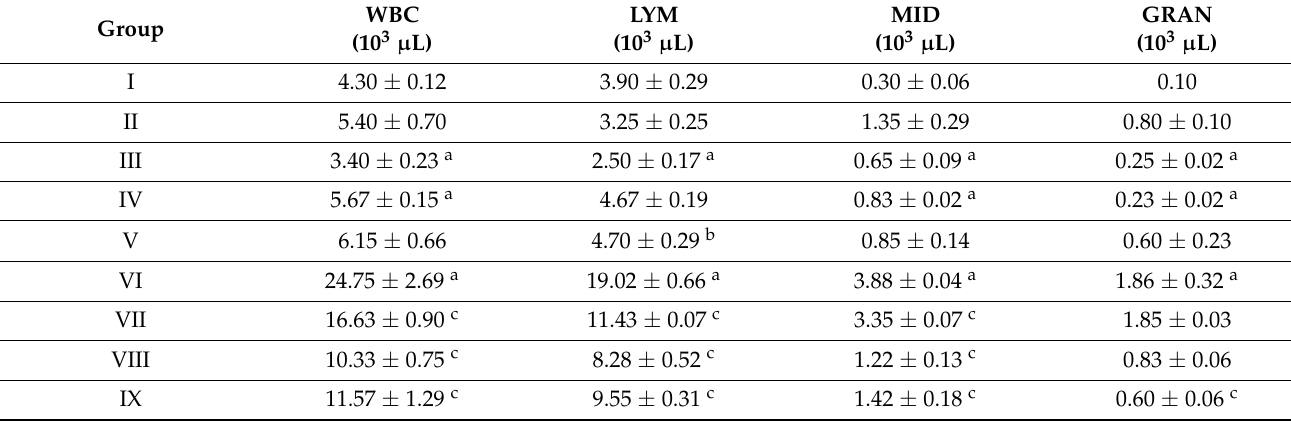
Table 5. Changes in leucocytes of mice after 2 weeks of the